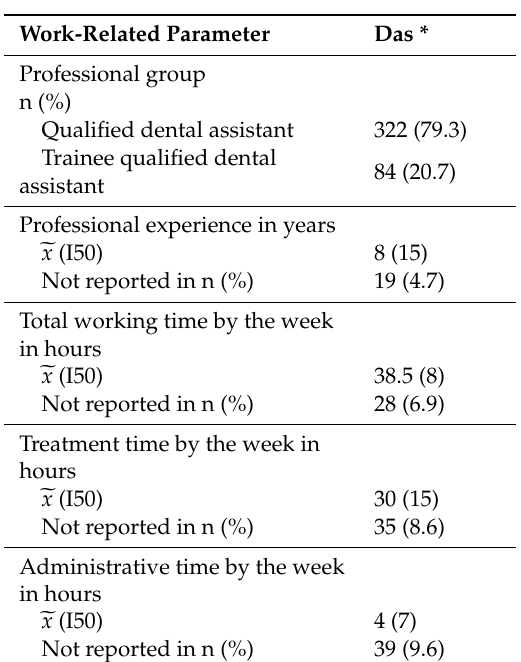
Table 2. Work -related characteristics of the study population.